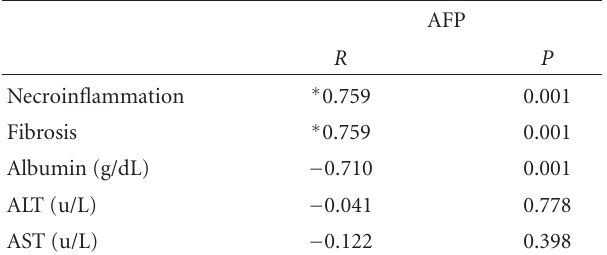
Table 2: The Pearson’s Correlation between pathological and biochemical parameters with AFP in CHC patients with